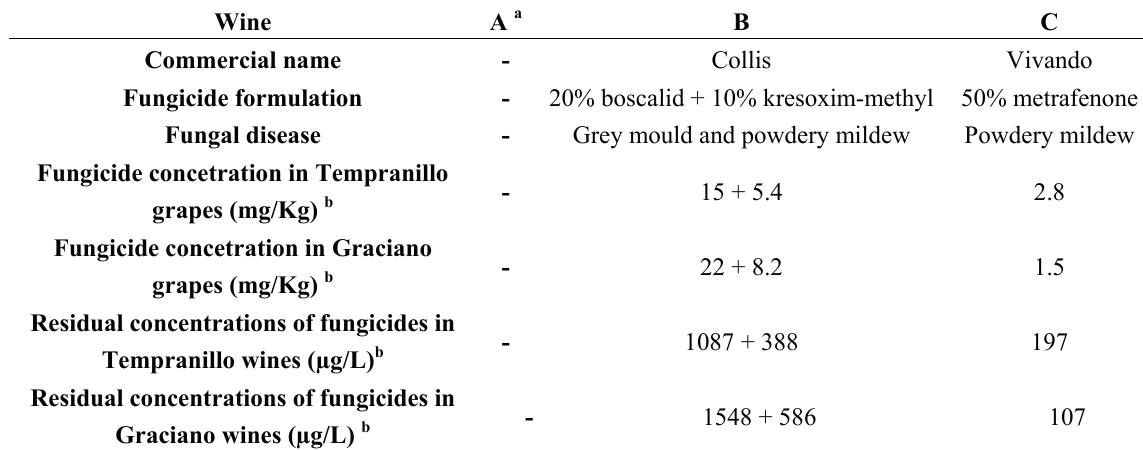
Table 3. Commercial formulations used in open-field